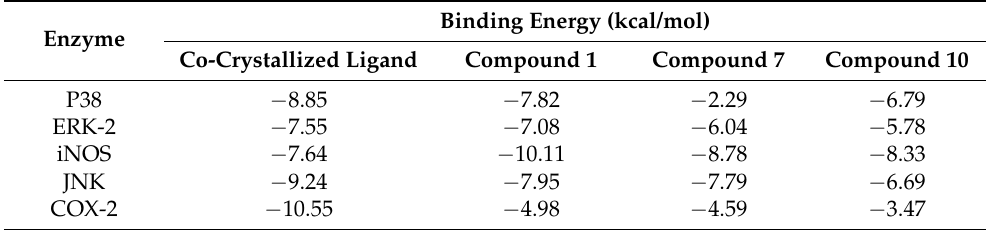
Table 2. Comparison of binding energy between compound 1, 7, and 10 with target enzyme inhibitors.